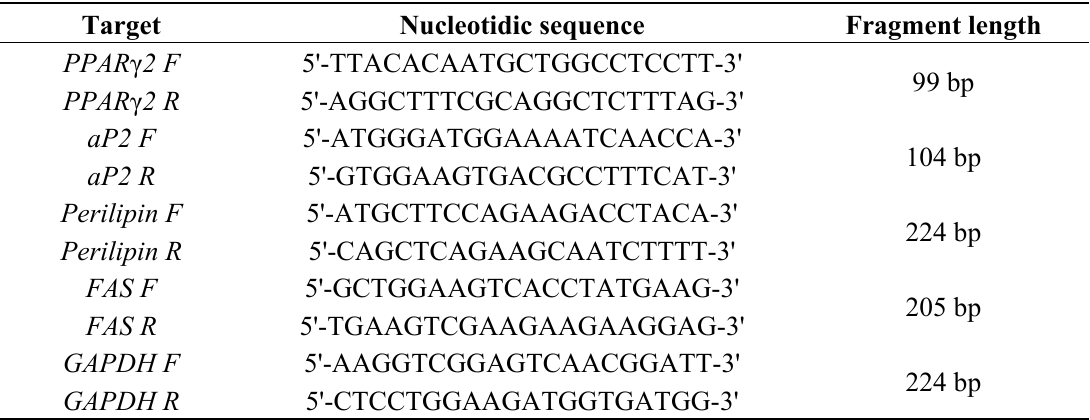
Table 4. Forward and reverse sequences of primers used to identify early and late adipogenic